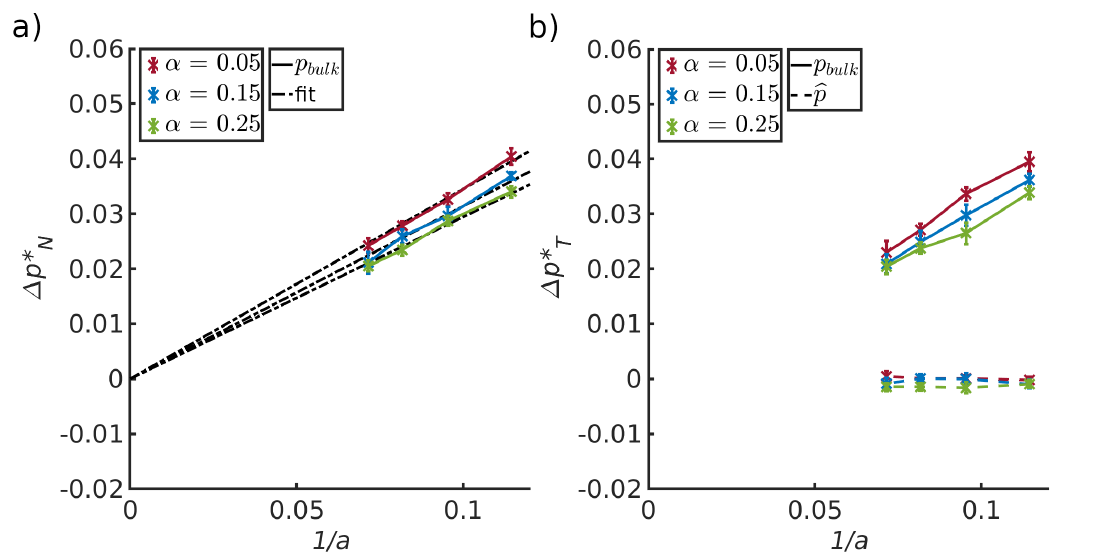
Figure 6. Difference between ( a ) the normal components of the pressure of the bulk liquid and vapor and ( b ) the difference in the tangential component of the pressure of the bulk liquid and vapor, for three different solid-fluid interactions ( α ) plotted as a function of the inverse half pore width. The bulk pressure, p f and the integral pressure are represented by solid and dashed lines, respectively.